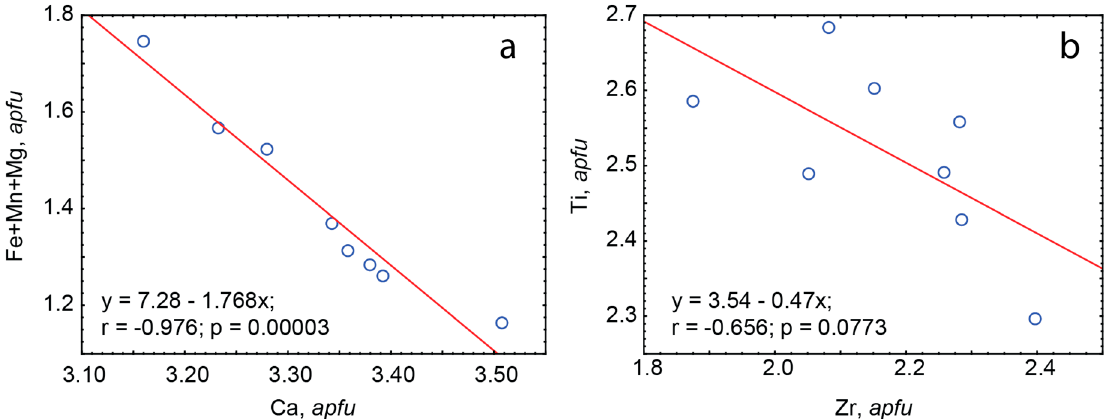
Figure 3. The relations between the cation contents in the B ( a ) and C–D ( b ) sites in chirvinskyite.